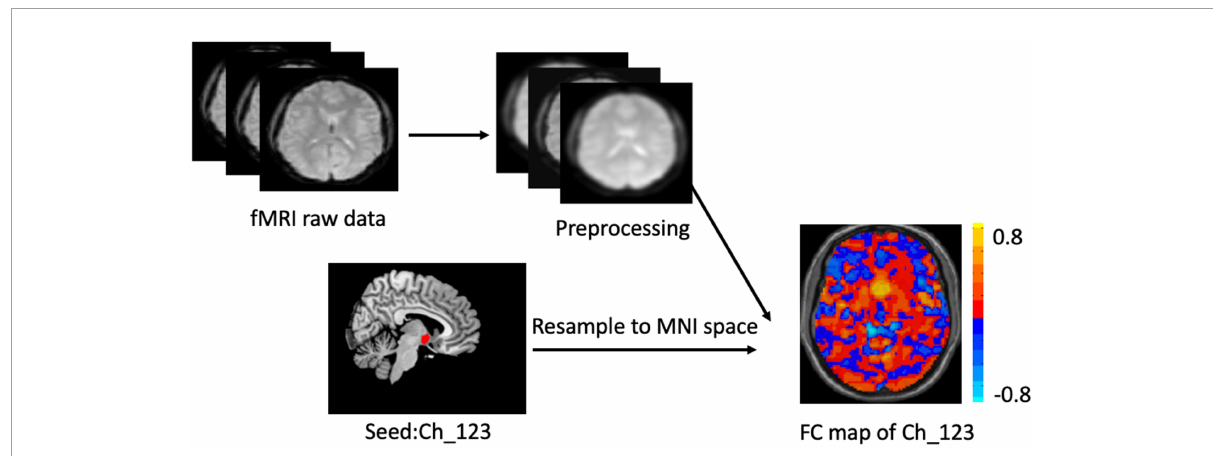
FIGURE2 Flow chart of the seed_based functional analysis. Illustration of Ch-123 based functional connectivity (FC). Warms color in the FC map represents voxels with positive correlation with Ch_123, while cold colors represent voxels with negative correlation with